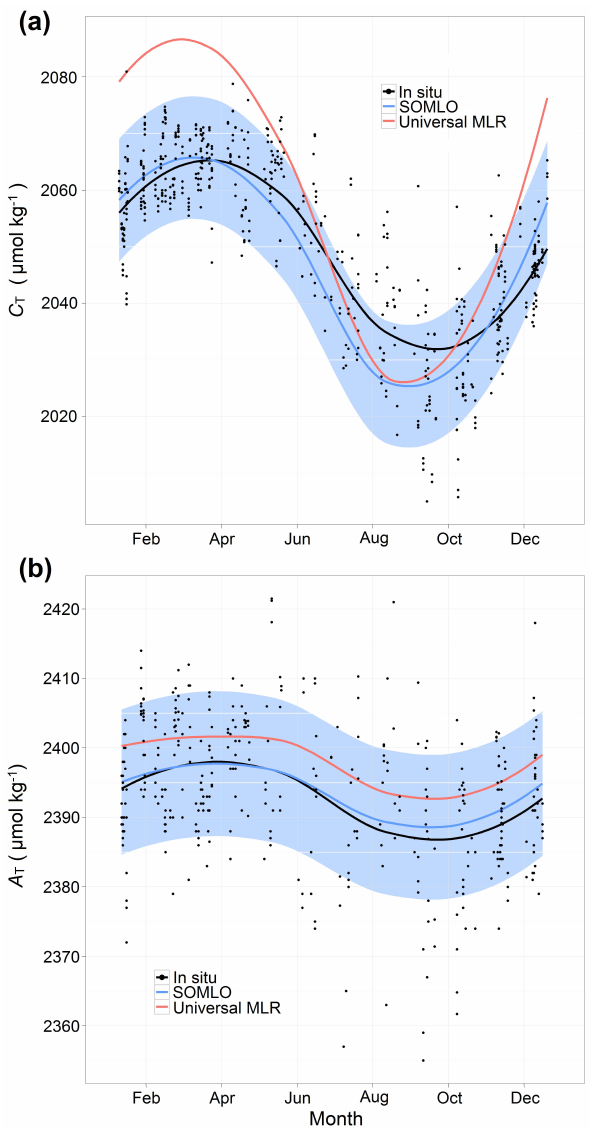
Fig. 15. BATS in situ and independently predicted seasonal cycles for (a) C T and (b) A T . Black dots show the in situ measurements and blue shaded region represents the uncertainty in SOMLO pre- dictions.